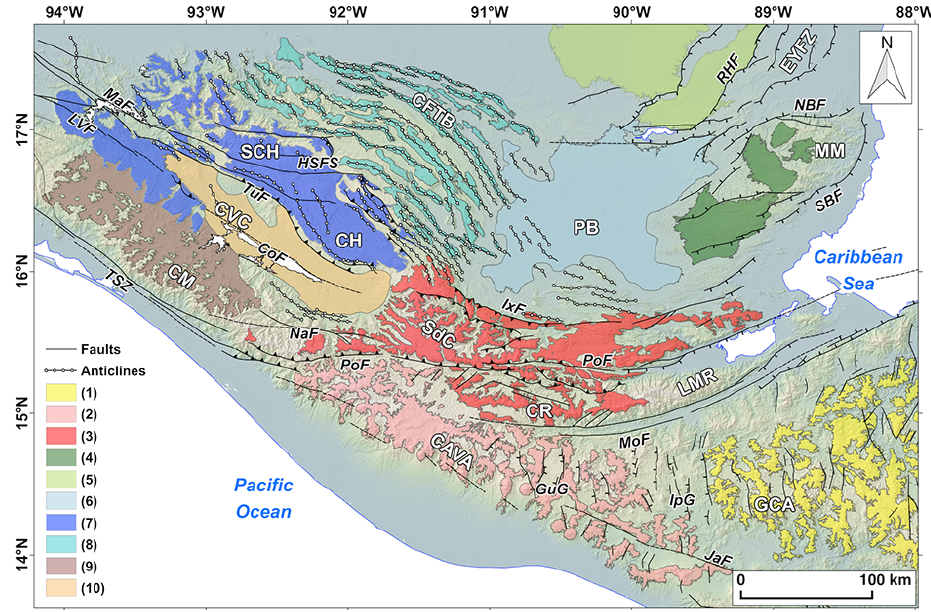
Figure 17. Proposed extension of elevated surfaces and relict landscapes in northern Central America (interpretative map based on morpho- metric maps, Figs. 7 and 8). Legend: 1 – remnants of the Miocene ignimbritic plateau (Rogers et al., 2002); 2 – Plio-Quaternary volcanic arc plateau; 3 – middle Miocene Mayan paleosurface (Authemayou et al., 2011; Brocard et al., 2011); 4 – relict landscape of the Maya Moun- tains; 5 – tilted surfaces of the Yucatán platform; 6 – Petén Basin; 7 – elevated plateaus of La Venta and northern Sierra Madre de Chiapas; 8 – inferred extension of the plateau within the fold-and-thrust belt; 9 – monadnock landscape developed over the Chiapas batholith; 10 – Central Valley of Chiapas. See Fig. 2 for faults and morphotectonic domain